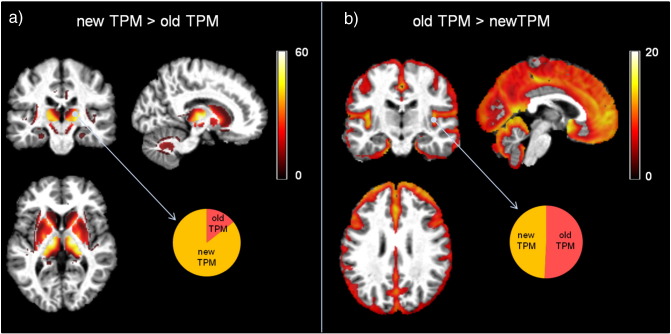
Statistical parametric maps of paired t-test between gray matter (GM) volumes estimated from T1-weighted data with new and conventional tissue probability maps (TPM) at statistical threshold of pFWE < 0.05. (a) Increase of GM volume estimation, based on the new TPM, compared to the estimation based on conventional TPM. (b) Increase of GM volume estimation, based on the old TPM, compared to the estimation based on conventional TPM. The pie charts represent the effect size for the indicated brain location. All results are presented at pFWE < 0.05.